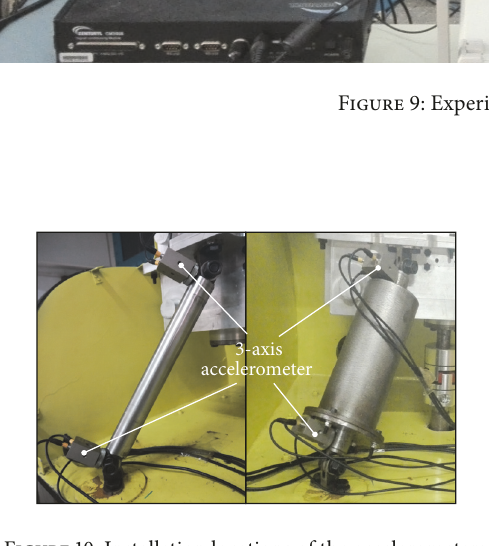
Figure 10: Installation locations of the